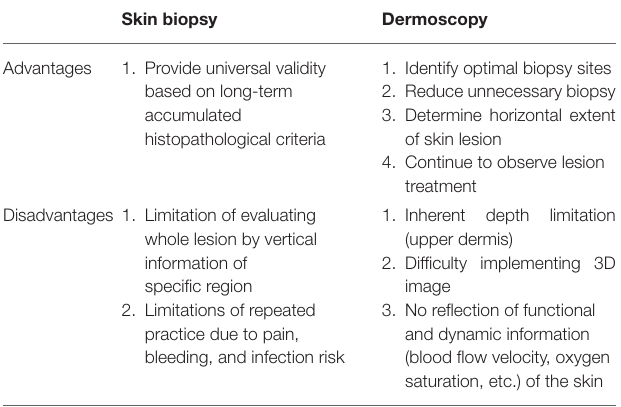
TABLE 2 | Device resolution and imaging depths 1